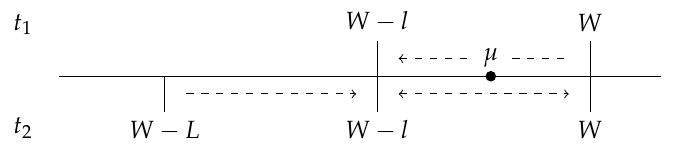
Figure 2. Wealth prospects over the two